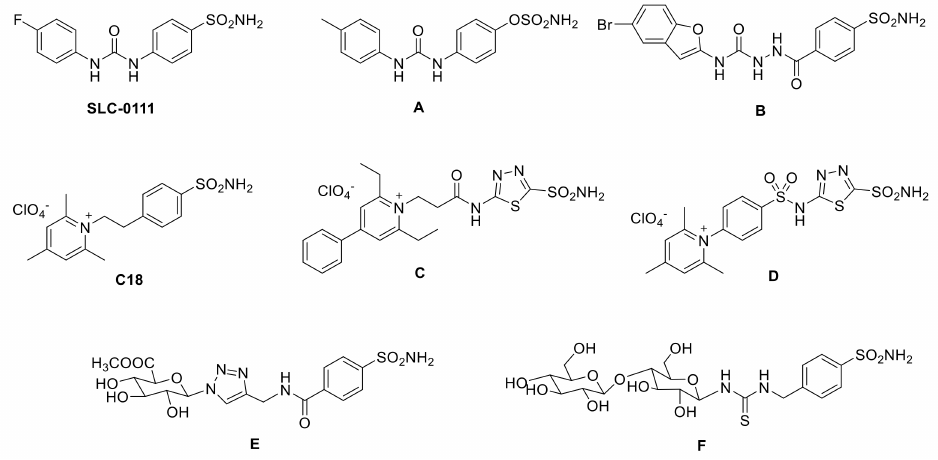
Figure 3. Structure of SLC-0111 and its analogue derivatives, A and B ; the membrane impermeant pyridinium CAIs, C18 , C , and D ; sugar-tailed CAIs, E and F